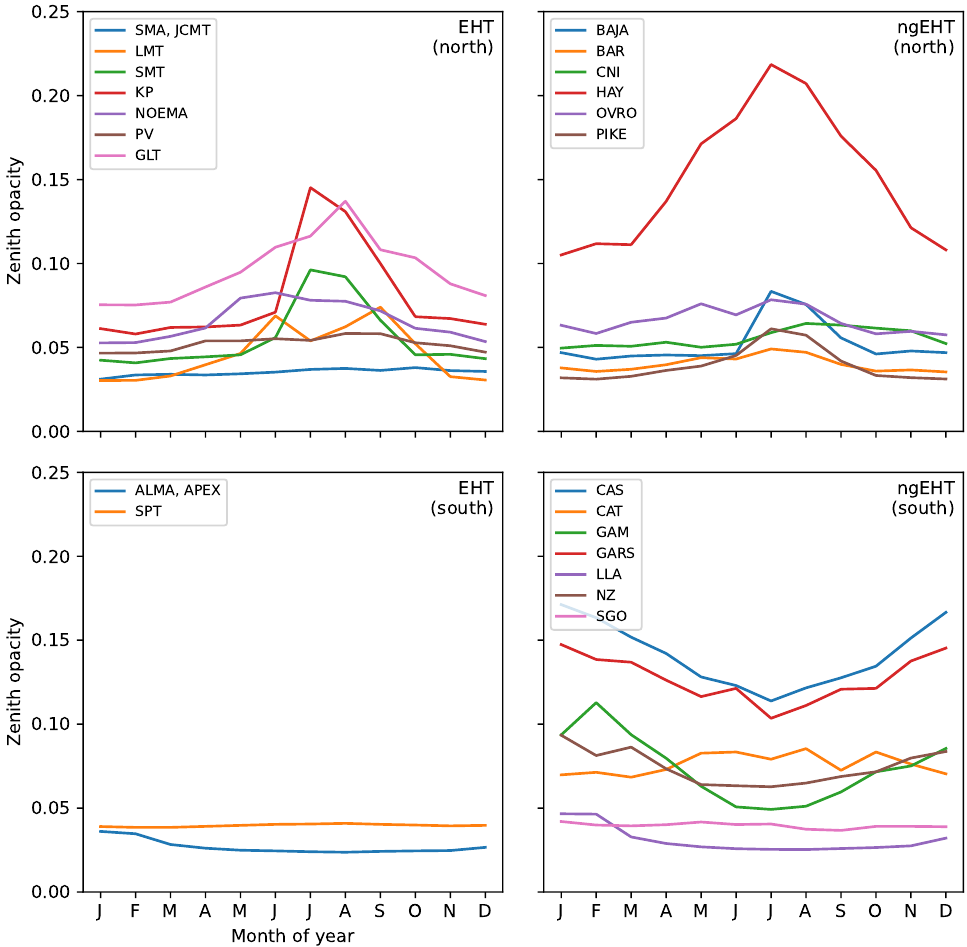
Figure 5. Median-zenith atmospheric opacity at 86GHz as a function of time at each of the sites in the EHT ( left panels ) and ngEHT ( right panels ) arrays; the sites are split by hemisphere. The top row shows northern hemisphere sites, and the bottom row shows southern hemisphere sites. We note that for frequencies below ∼ 130GHz, the atmosphere over Chajnantor is typically more transparent even than that over the South Pole (e.g.,